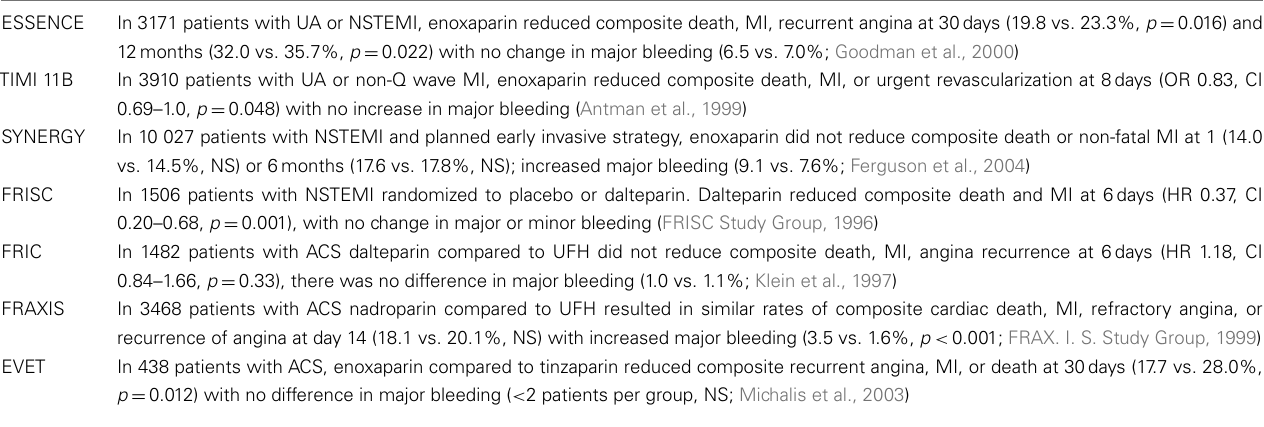
Table 2 | Low molecular weight heparins